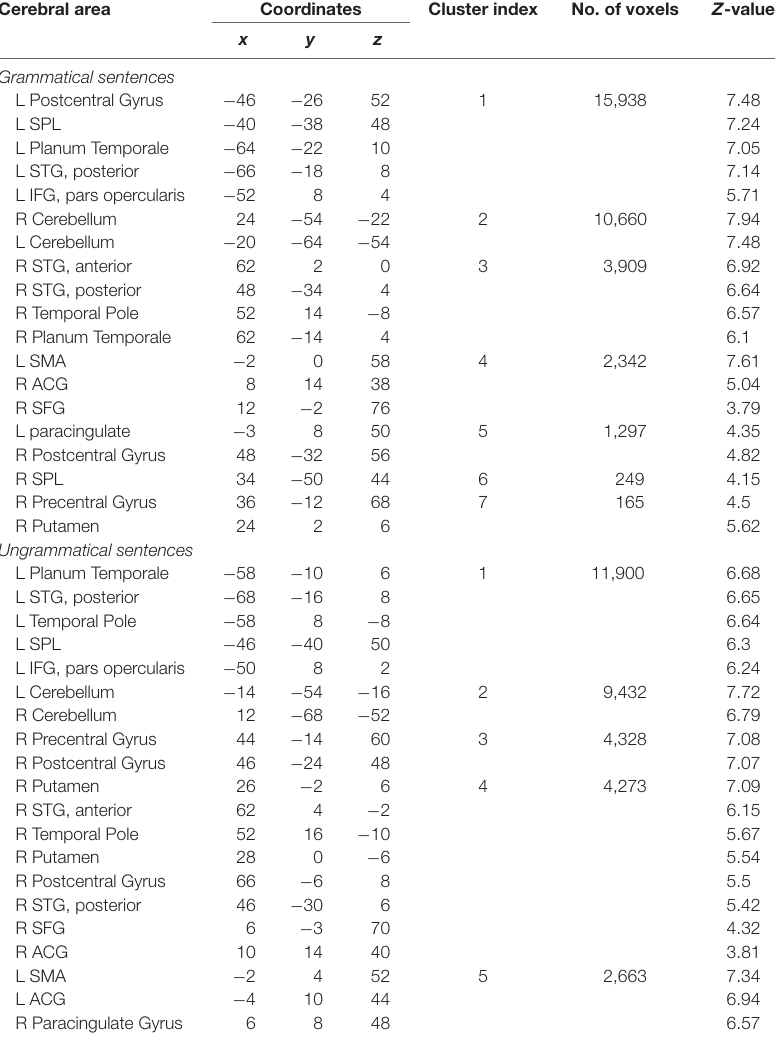
TABLE 3 | Brain regions involved in L2 separately for each condition compared to the baseline (whole-brain analyses). Cerebral